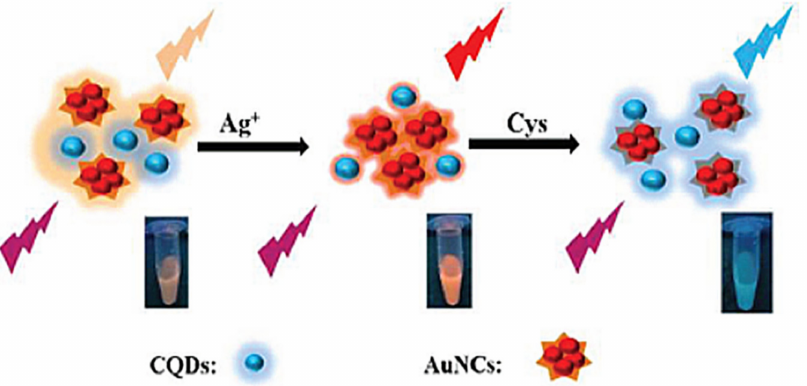
Figure 4. Schematic illustration of the detection of Ag + and L-cysteine with dual emissive nano system of CQDs and AuNCs [93]. Reproduced with permission from Han et al., Anal. Method. ; published by The Royal Society of Chemistry,